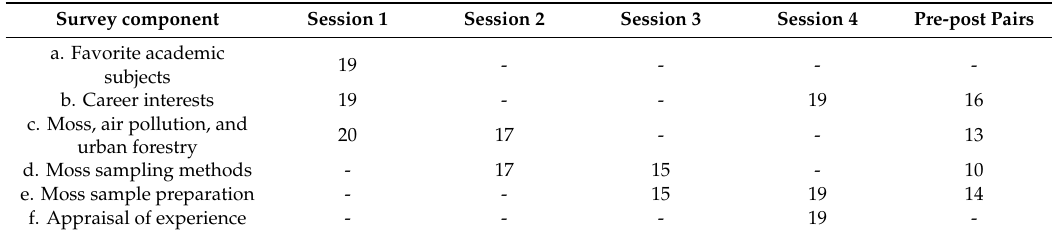
Table 2. Number of youth participants completing survey components during pilot